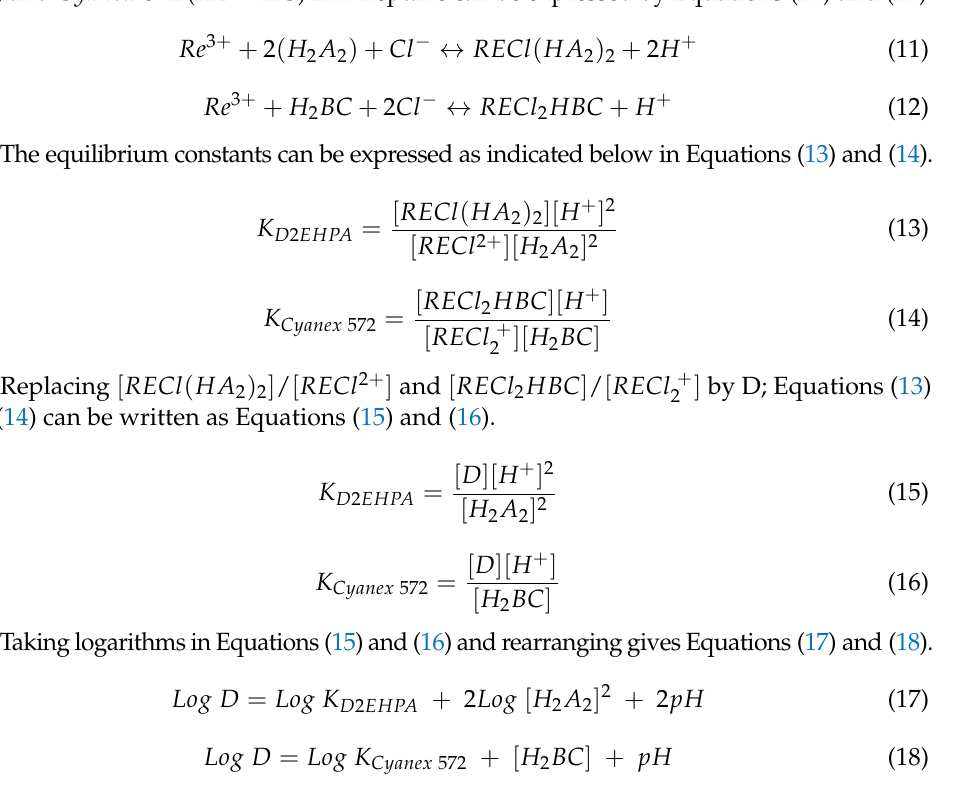
Figure 15. Effect of pH on the extraction of La , Ce and Nd in: D 2 EHPA ( a ) and CY572 ( b ). The extractants D 2 EHPA and Cyanex 572 extract the metal from the aqueous solution by hydrogen ion exchange; these extractants produce dimers through hydrogen bonds, which can be represented by ( HA ) 2 or H 2 A 2 for D 2 EHPA and H 2 BC for Cyanex 572 [20,50]. Therefore, based on the analysis of the slopes of the Log D vs. pH plots, the extraction reactions of trivalent rare earths ( RE 3 + ) in a leach liquor in chloride medium with D 2 EHPA ( HA ) and Cyanex 572 ( HB + HC ) in n-heptane can be expressed by Equations (11) and